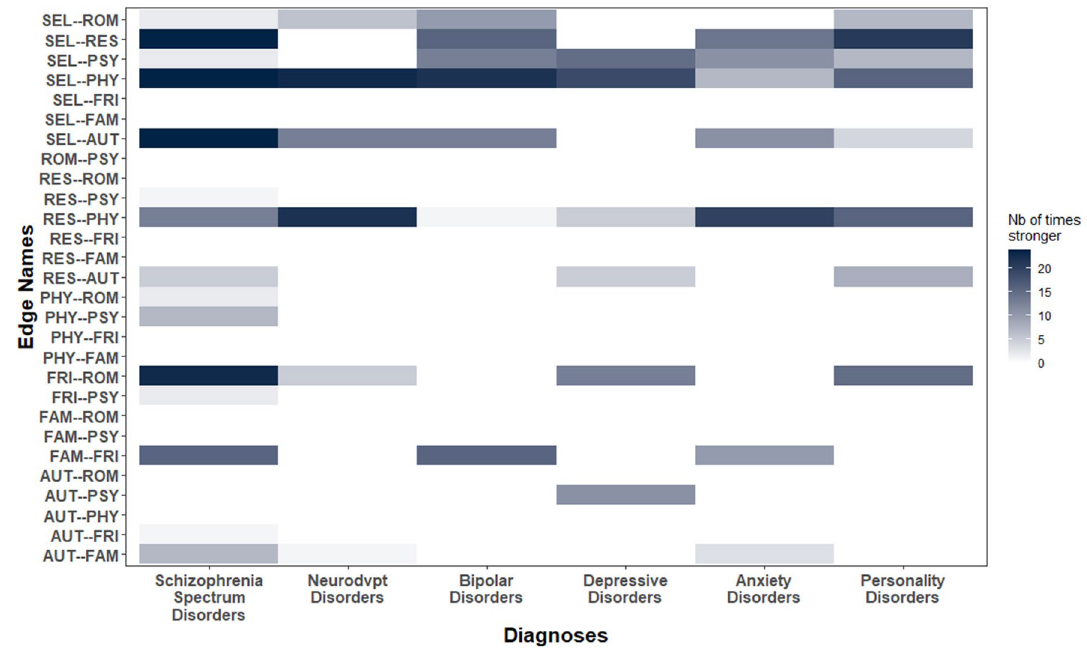
Figure 3. Relative importance of edges connecting quality of life dimensions among the six diagnosis groups. For each diagnosis group (X axis), each tile represents the number of times each edge (Y axis) shows significantly greater weight than other edges. Quality of life dimensions: SEL self-esteem, ROM romantic life, RES resilience, PSY psychological well-being, PHY physical well-being, FRI relationships with friends, FAM family relationships, AUT autonomy.